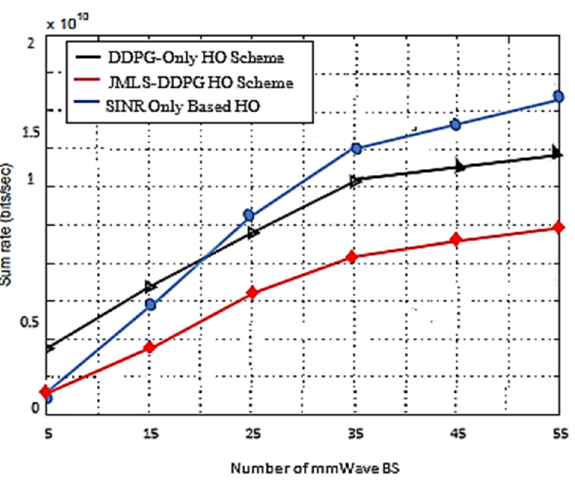
Figure 11. Sum rate for three HO schemes as a function of the number of BSs.